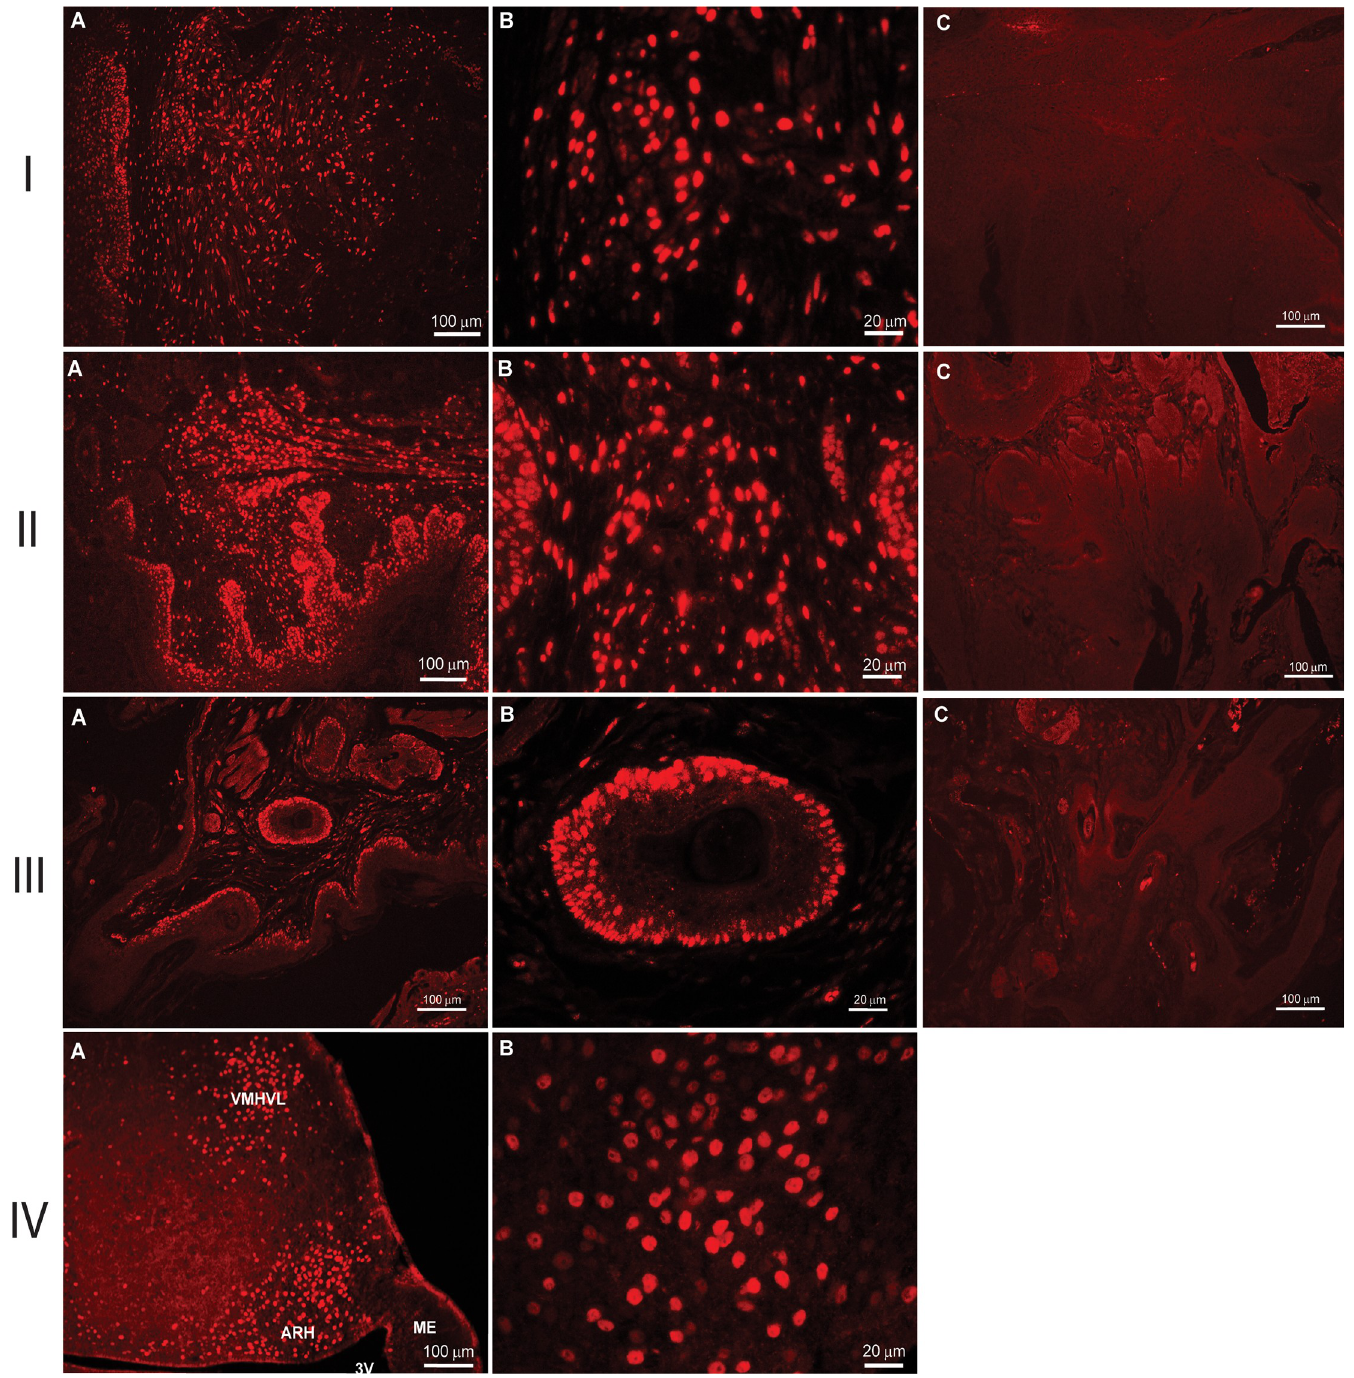
Fig 9. Estrogen Receptor alpha (ER α ) is present in the KC anal tissue. The presence of ER α was detected using immunofluorescence IHC. ER α was found to be present in the anal SCC of intact KC female mice (I), in the anal epithelium of ovariectomized KC female anus lacking tumor formation (II) and in the KC male anus (III). Panels A and B show the fluorescent staining of the receptor at 10x and 40x respectively. Panel C in each group shows the tissue with only the use of the secondary antibody confirming no off target staining. Group IV shows ER α staining of mouse arcuate nucleus as the positive control [15].